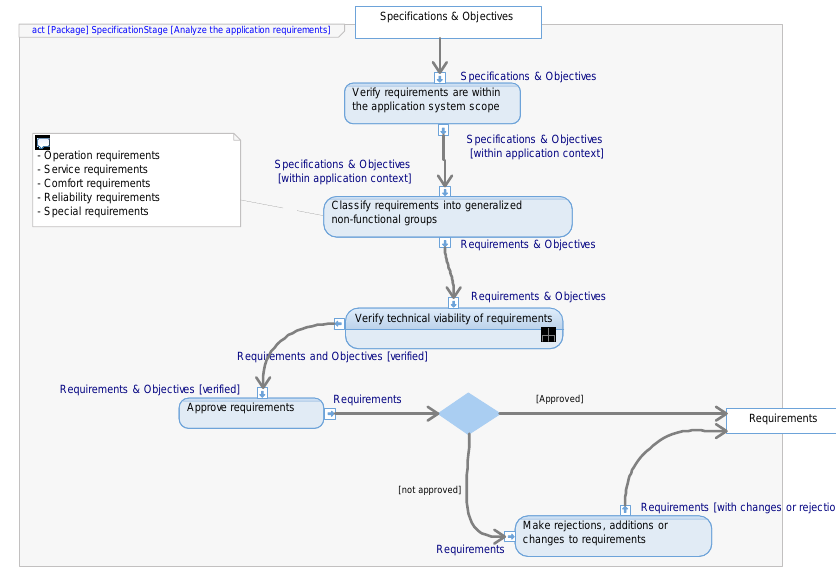
Figure 5. Analyze the application requirements activity.